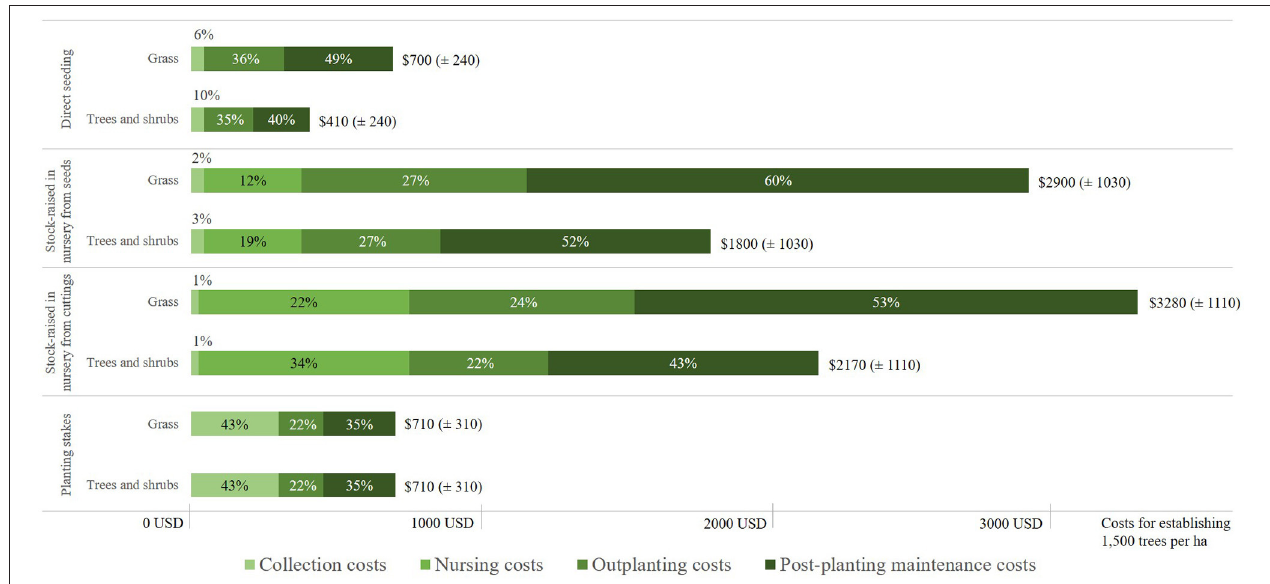
FIGURE 2 | Share of the different cost pools in the total costs (approximate mean values and the associated standard deviations) of different restoration approaches on sites with a vegetation consisting predominantly of grass (former pasture sites) or trees and shrubs. All other cost drivers where assumed to have a medium effect on costs (e.g., medium genetic